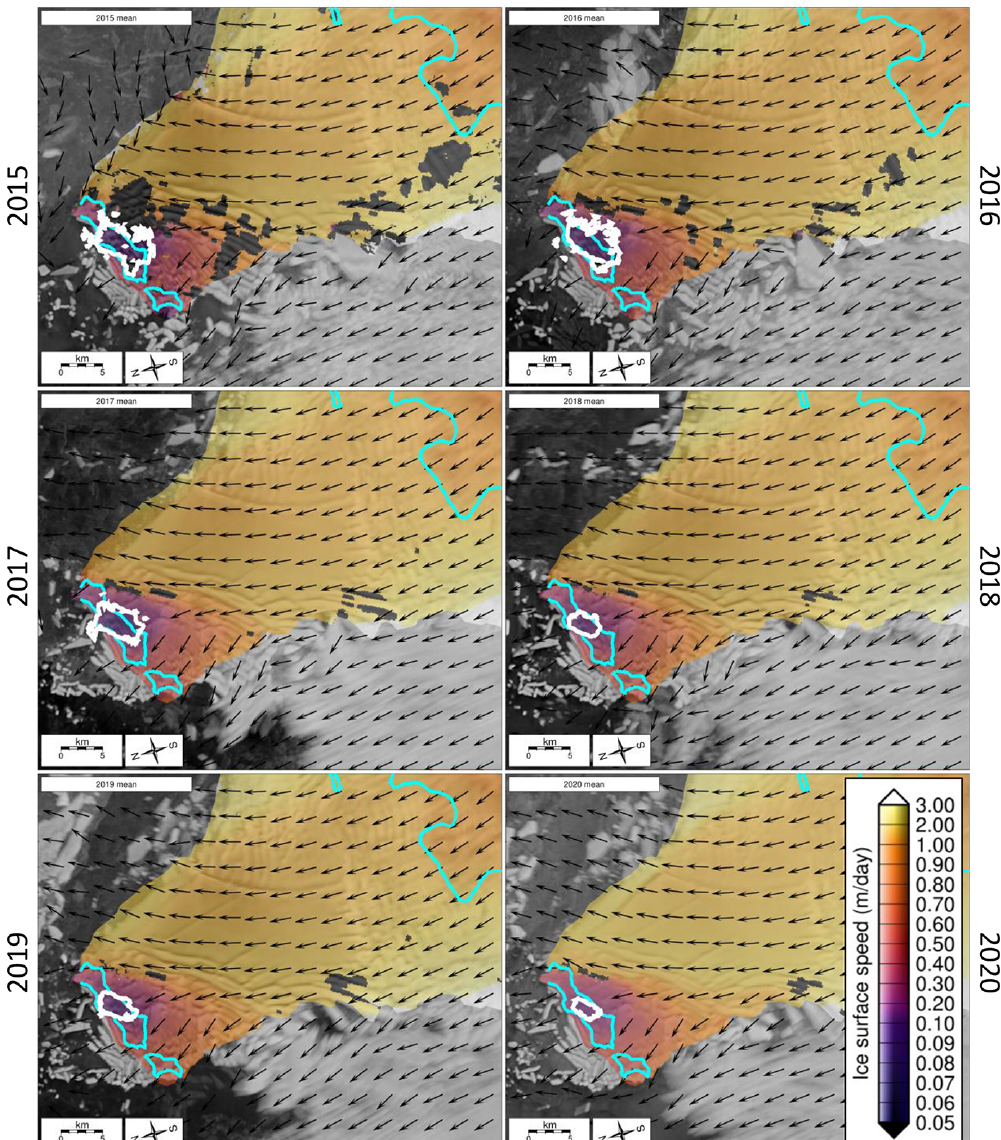
Figure 2. Time series of mean annual velocity from TEIS derived from Sentinel-1 speckle tracking between 2015 and 2020. Arrows show flow direction and indicate no significant change in flow orientation during this period. White lines delineate the 0.2md − 1 velocity contour which is centred on the main established pinning point. Sustained shrinkage over time of the area bounded by this contour confirms that TEIS is losing contact with the pinning point as the shelf thins (Alley et al., 2021; Wild et al.,